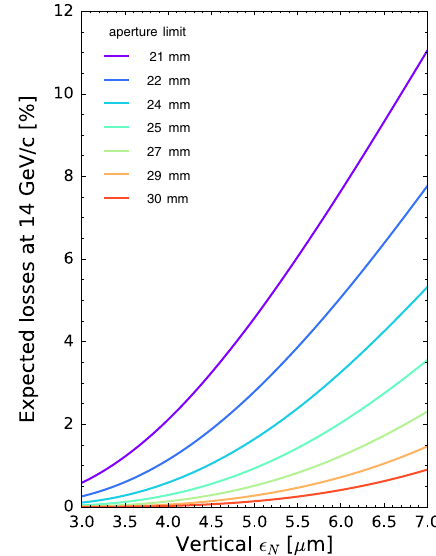
FIG. 16. Expected losses at the SPS flat bottom as a function of the vertical normalized emittance due to the global aperture bottleneck (transition between the MBA and MBB